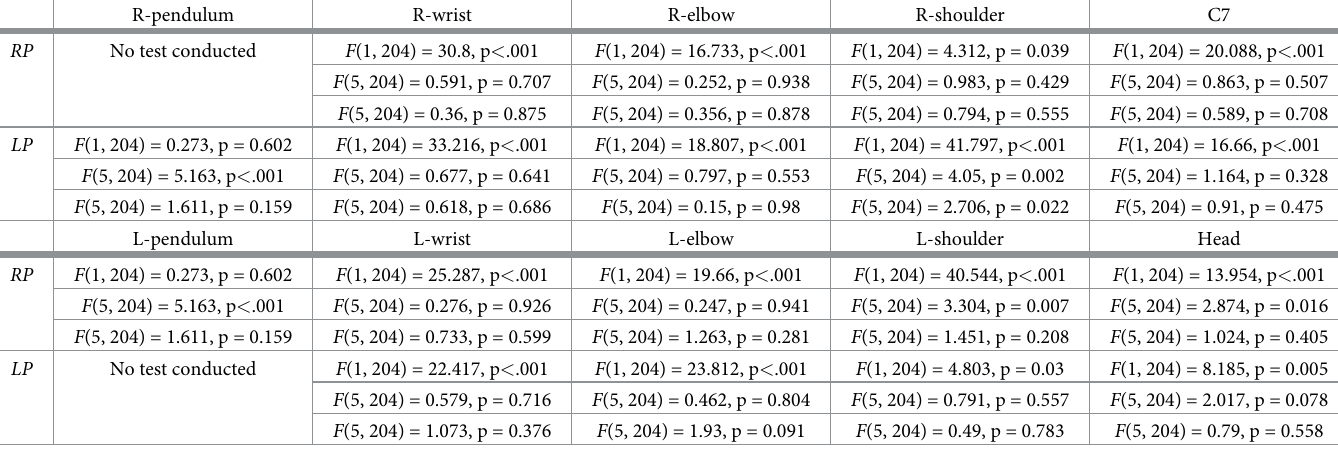
Table 2. Results of two-way ANOVA for first peak value of cross-correlation (anti-phase condition). R-pendulum R-wrist R-elbow R-shoulder